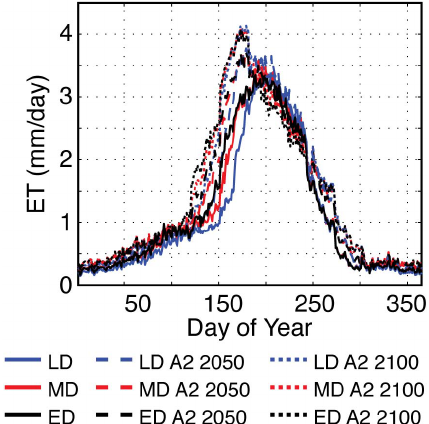
Fig. 12. Simulated median daily evapotranspiration over all model years for the grid cell containing Senator Beck Basin. Only the A2 climate scenario is shown, for